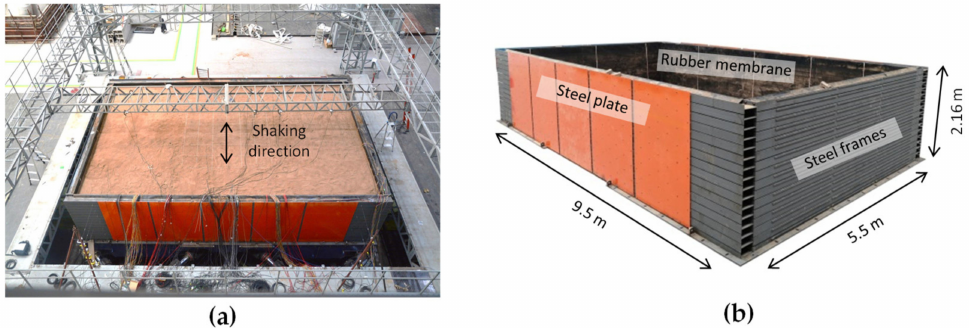
Figure 2. Laminar box used for the shaking table tests. ( a ) Overview of the soil container installed on the multifunctional shaking table of Tongji University and ( b ) its key